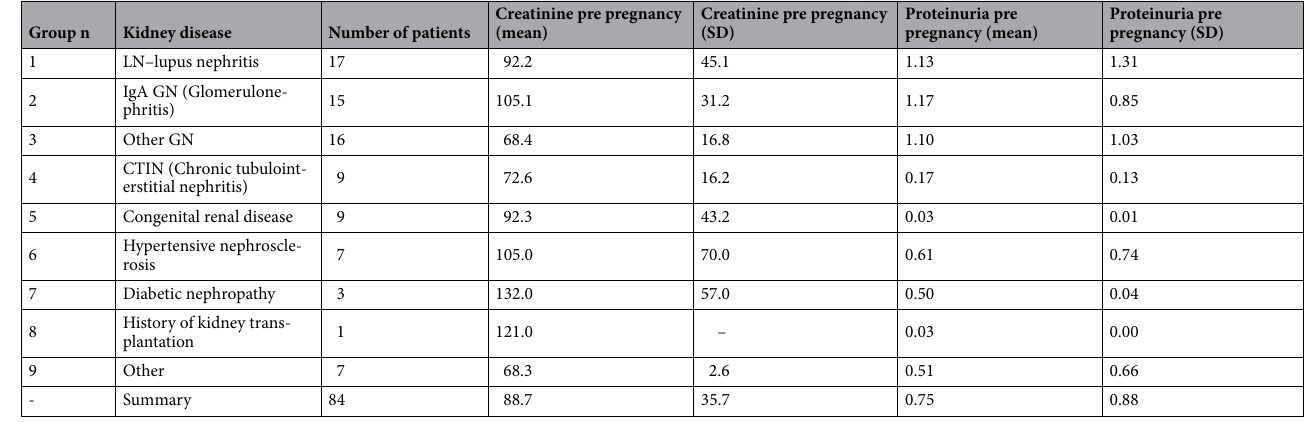
Table 2. Creatinine and proteinuria